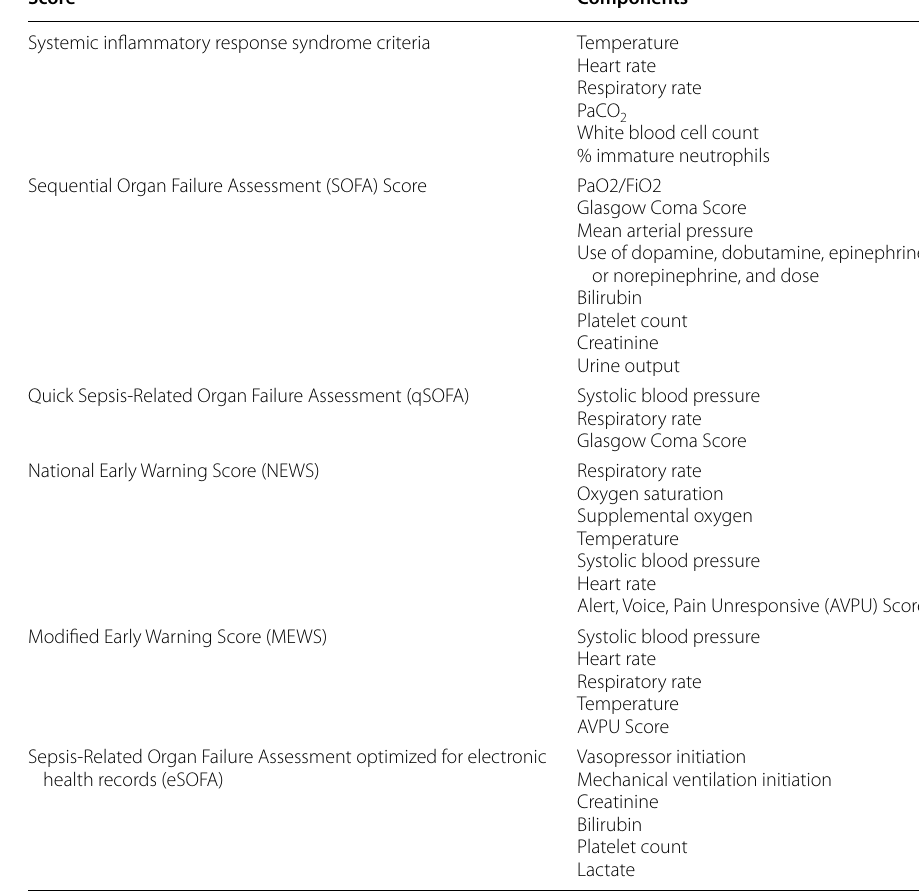
Table 1 Scoring systems used for patients with sepsis and the components that contribute to them